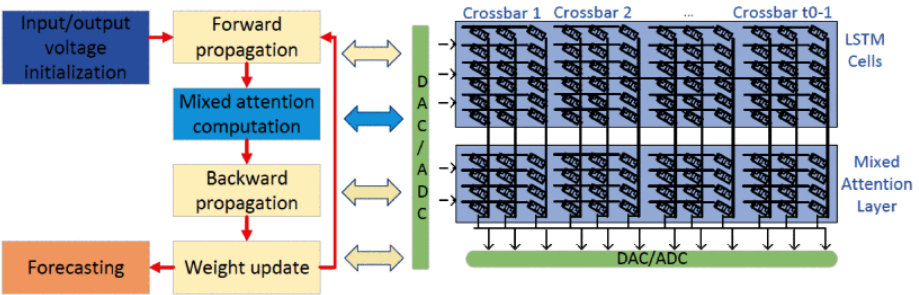
Figure 8. The update of the hidden state of the multivariate LSTM [144].